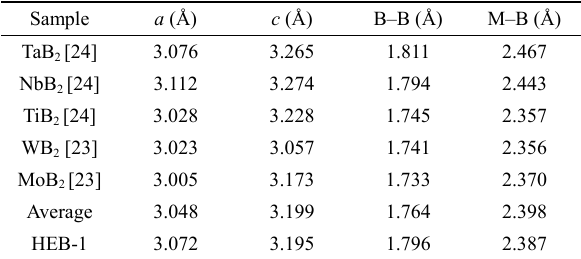
Table 1 Unit cell parameters and bond lengths of the as-synthesized HEB-1 products at 1423 K by XRD refinement and five individual diborides and the “average” values represent the means of five individual diborides